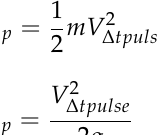
where 𝑉 ∆(cid:3047)(cid:3043)(cid:3048)(cid:3039)(cid:3046)(cid:3032) is the uplifting velocity (m/s), which is also named ‘launch velocity’ where V ∆ tpulse is the uplifting velocity (m/s), which is also named ‘launch velocity’ com- computed from Equation (36) and net impulsion ( I net ) shown in Equation (28). puted from Equation (36) and net impulsion ( I net ) shown in Equation (28).